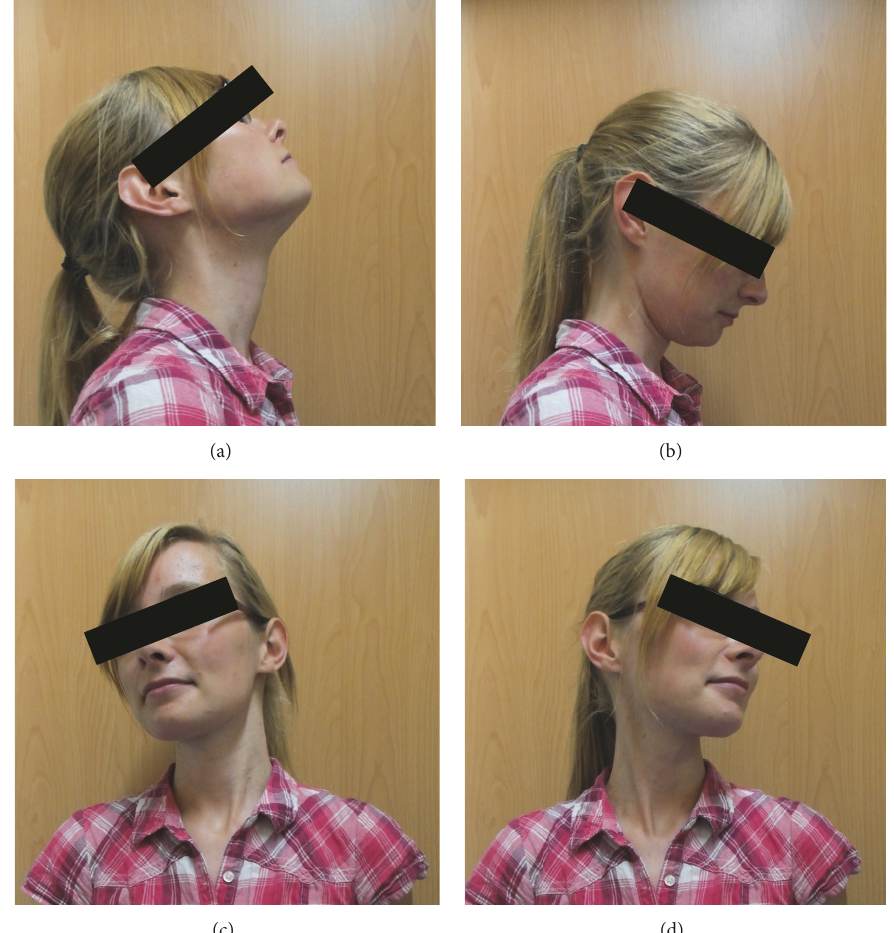
Figure 4: Range of motion after 5.5 months (1.5 months after removal of halo fixation): (a) declination, (b) inclination, and (c) and (d) right and left